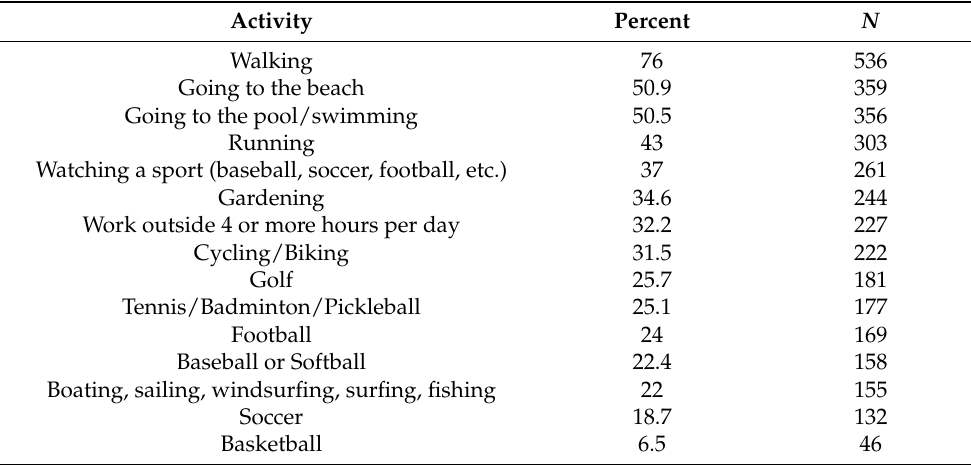
Table 2. Participants’ regular outdoor sun exposure activities ( n = 705).